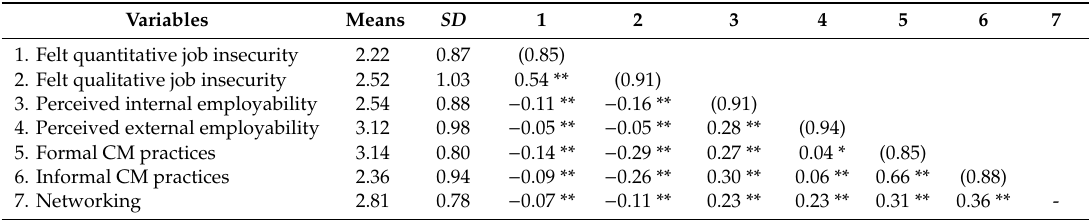
Table 2. Means, standard deviations and correlations for the study variables of Sample